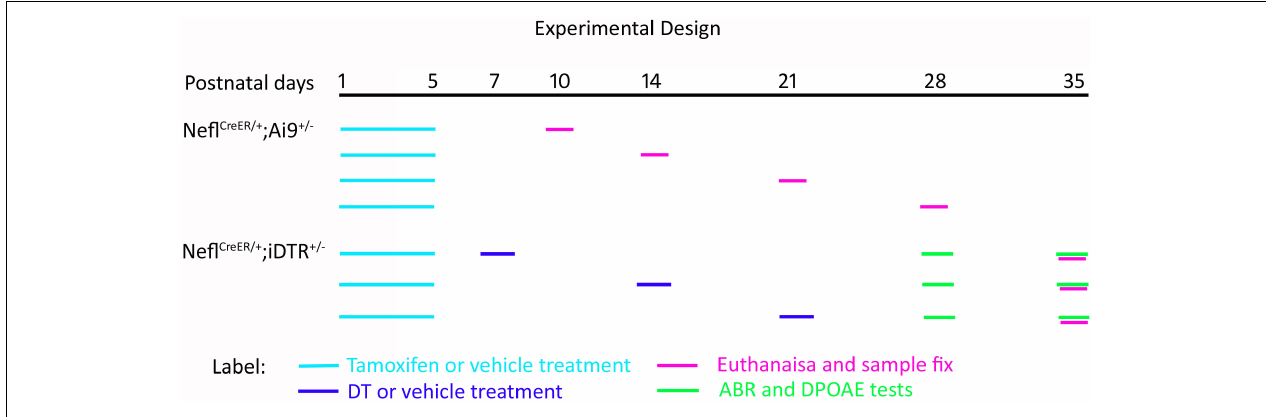
FIGURE 1 | Schematic diagram of the experimental design. Nefl CreER / + ;Ai9 + / − mice were treated with tamoxifen or vehicle on postnatal day 1 (P1) for 4–5 consecutive days. The pups were followed up and euthanized on P10, P14, P21, and P28. Nefl CreER / + ;iDTR + / − mice were treated with tamoxifen on P1–P5, followed by either vehicle or diphtheria toxin (DT) treatment on P7, P14, and P21. Hearing tests, including auditory brainstem response (ABR) and distortion product otoacoustic emission (DPOAE), were conducted on P28 and P35, and mice were euthanized on P35.